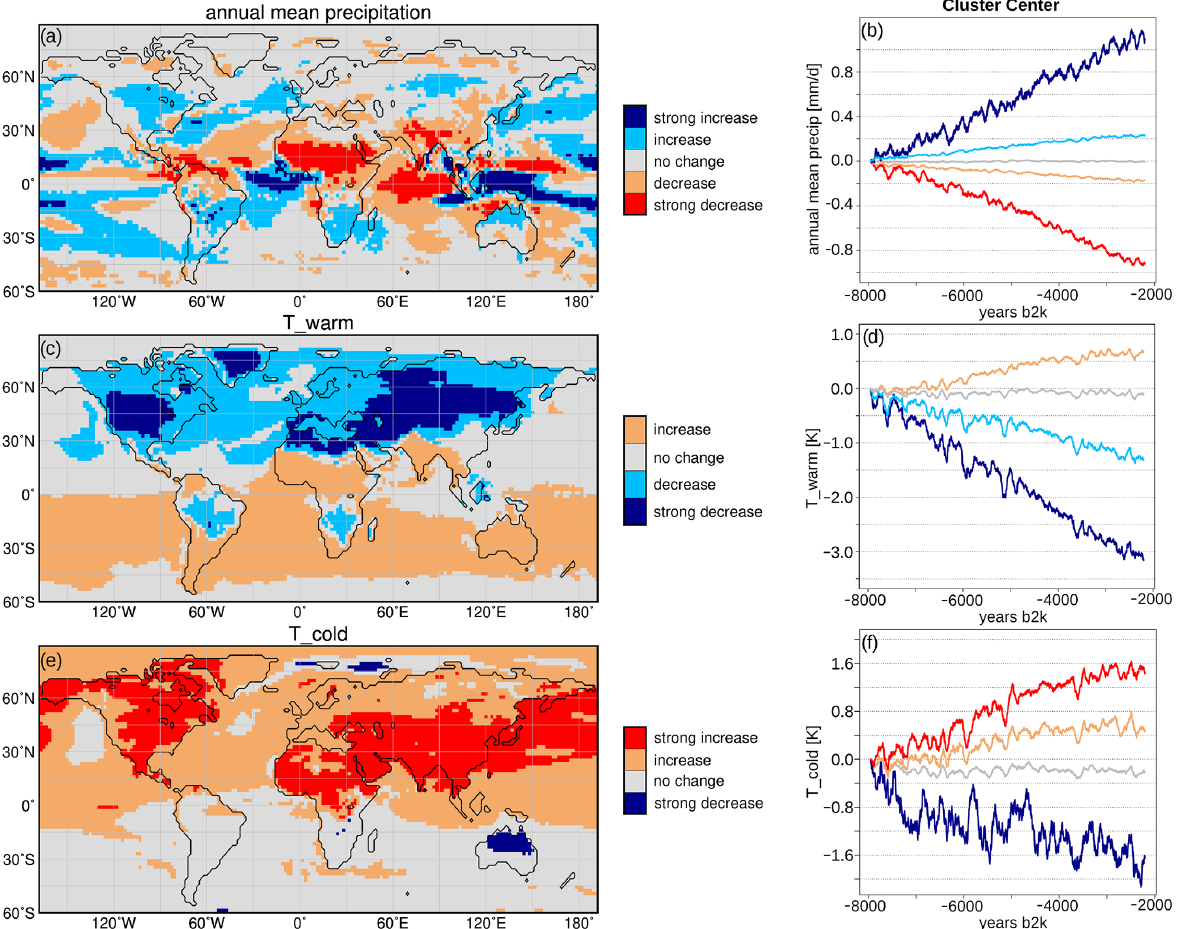
Figure 3. Simulated Holocene climate cluster, derived by c -means clustering method (R, Meyer et al., 2017). The left panel displays the cluster pattern for (a) annual mean precipitation, (c) temperature of the warmest month ( T warm ) and (e) temperature of the coldest month ( T cold ). The right panel shows the respective trends in the cluster centres, i.e. for (b) annual mean precipitation (mmd − 1 ), (d) T warm (K) and (f) T cold (K). For the analysis, 100-year running means of the anomaly time series (value at certain time step – 8ka climatological mean) have been